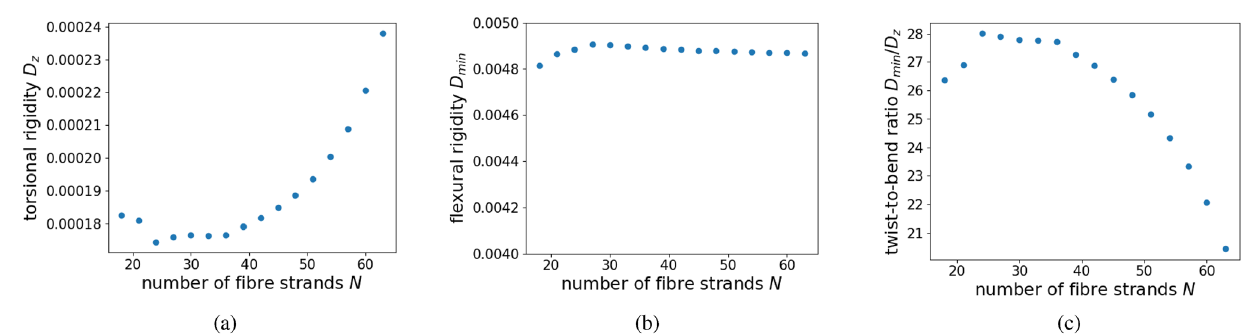
Figure 4. Reinforcement by sclerenchyma fibre strands. Trend of ( a ) torsional rigidity, ( b ) flexural rigidity and ( c ) twist-to-bend ratio. The ratio µ between the elastic moduli of the parenchyma and sclerenchyma is µ = 0.00044 . Sclerenchyma and parenchyma are the mechanically decisive materials for this experiment. By increasing the number of fibre strands used for reinforcement, torsional rigidity first decreases linearly, see ( a ), whereas the flexural rigidity remains nearly constant during the procedure, see ( b ). The twist-to-bend ratio first increases nearly linearly reaching a maximum for N = 49 . For more than 49 fibre bundles, the distance of single fibre bundles is too small and the torsional rigidity is caused to increase again, whereas the twist-to-bend ratio is reduced by this effect, see ( a ) and ( c ). The numerically computed values of the torsional rigidity are further interpolated using a first order polynomial regression (orange line). For up to 51 fibre strands, the torsional rigidity behaves as f ( N ) = a N + C , see ( a ), where C = 2.1 × 10 − 4 and a = 0.0031 . The R-squared value for the polynomial regression is 0.99.